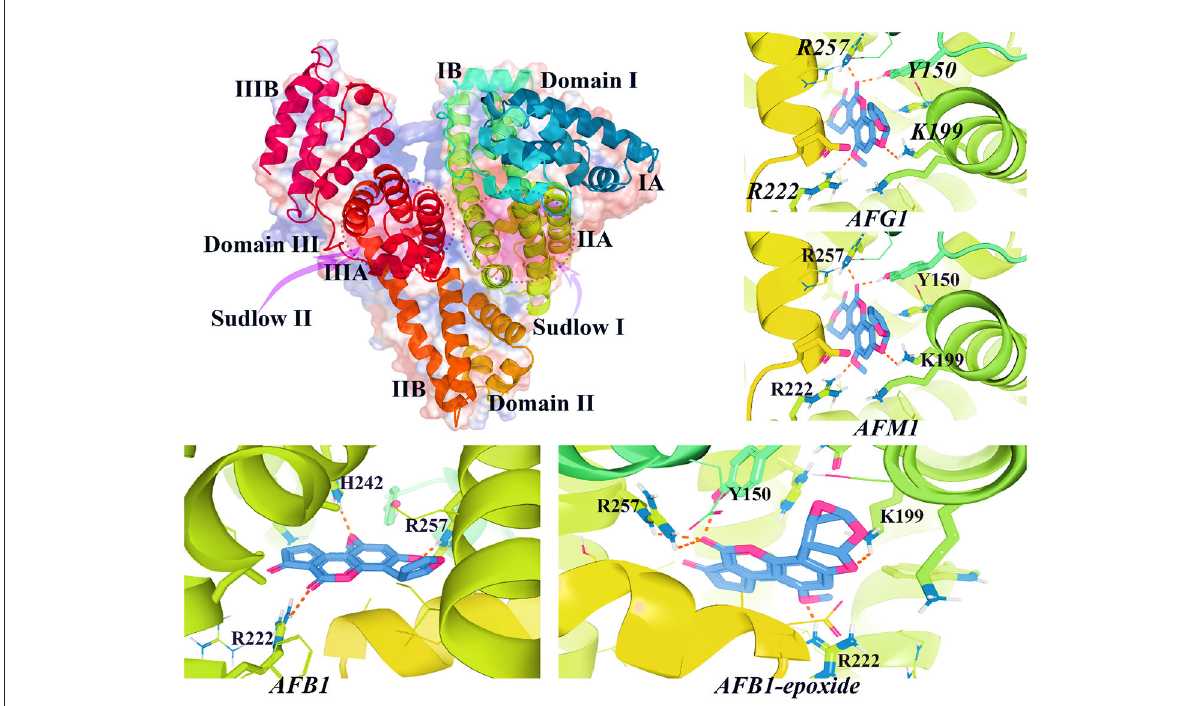
FIGURE9 The 3D structure of HAS (PDB id: 1AO6) and interacted AFs metabolites with HSA binding site I. As shown in this figure, AFs metabolites bind to critical active sites of HSA by forming H-bonds and other relevant chemical